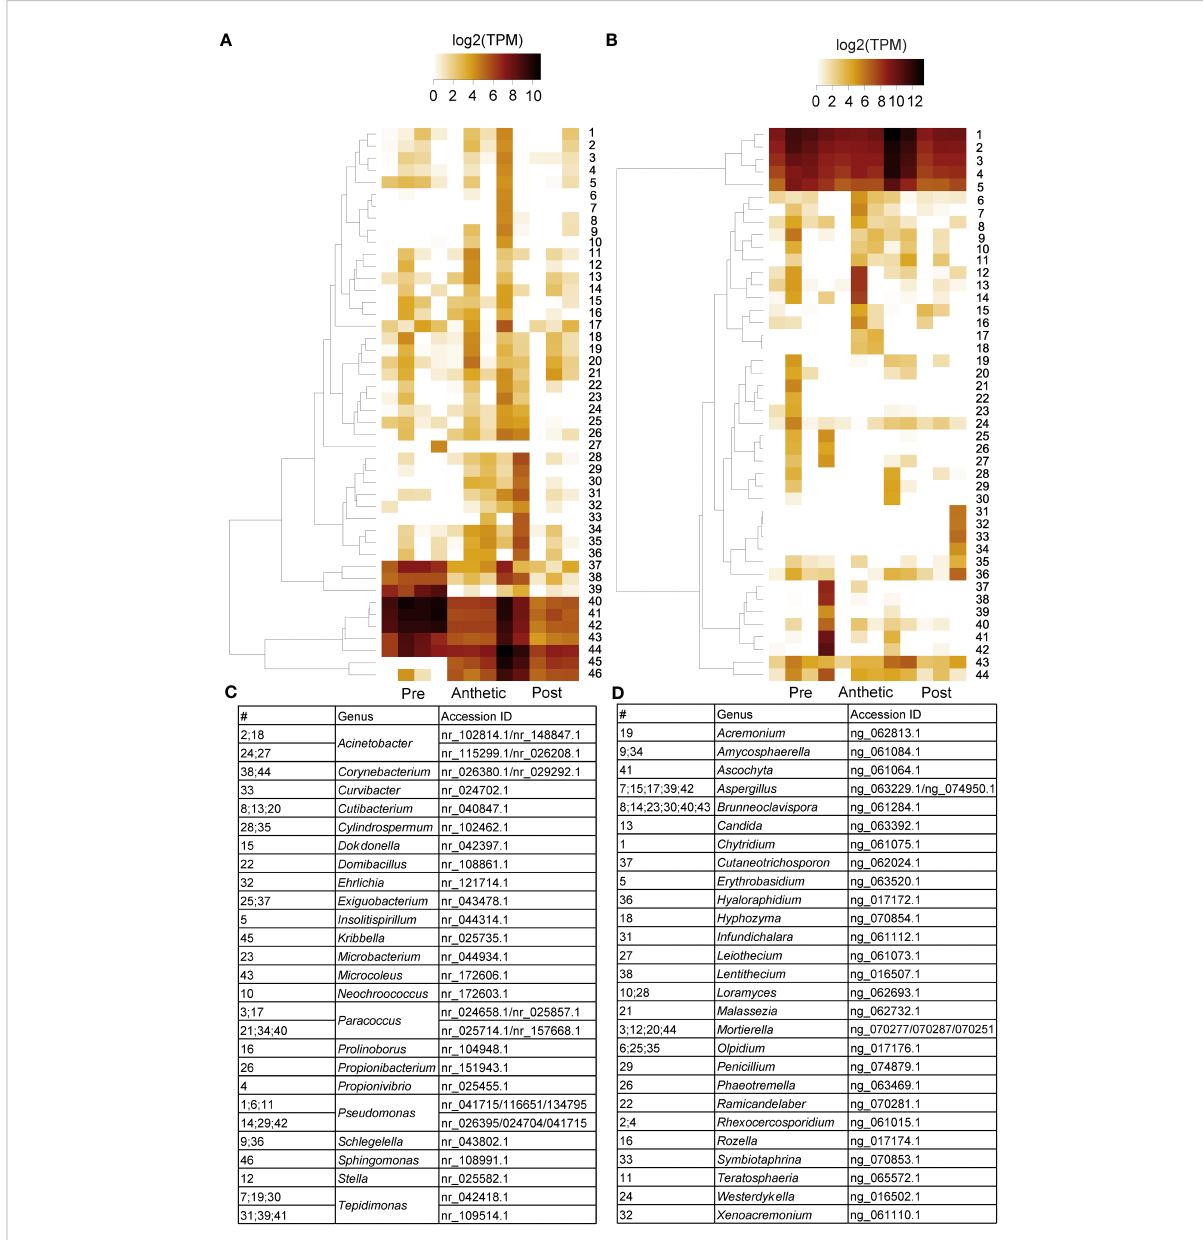
FIGURE 7 Heatmap of (A) 16s bacterial rRNA and (B) 18s fungal rRNA related transcripts in pre-anthetic, anthetic, and post-anthetic nectaries of Cleome violacea displayed in log2(TPM). Genera and NCBI accessions of respective transcripts for bacteria and fungi outlined in (C, D) ,